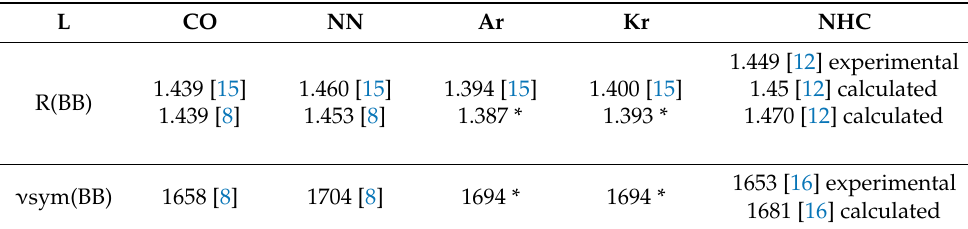
Table 1. Calculated BB bond lengths (in Å) and the BB frequency (in cm − 1 ) of the corresponding symmetric bond stretch for diboryne derivatives L-BB-L with a linear LBBL fragment.